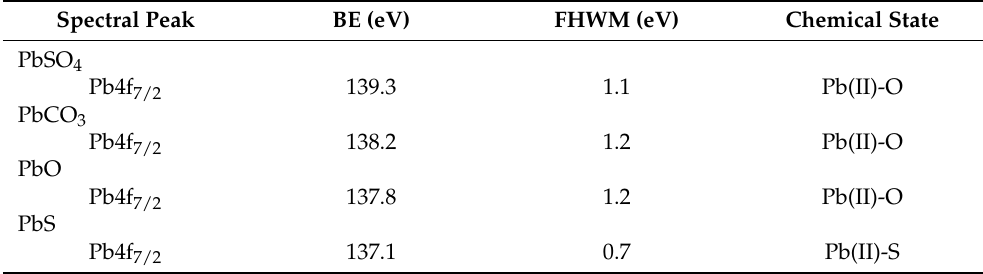
Figure 3. XPS narrow scan of the dolomite surface for samples after 15 d exposure to 1 mg/L PbCl 2 solution and the Pb4f 7/2 peak was split and fitted. The red line is the fitted line; Scan A: PbSO 4 ; Scan B: PbCO 3 ; Scan C: PbO; Scan D: PbS.